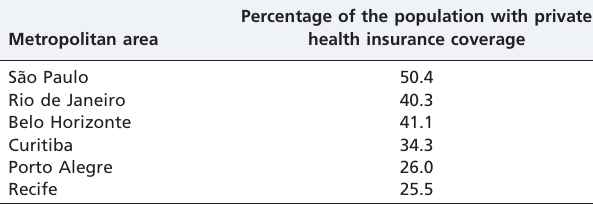
Table 6 - Percentage of the population with private health insurance